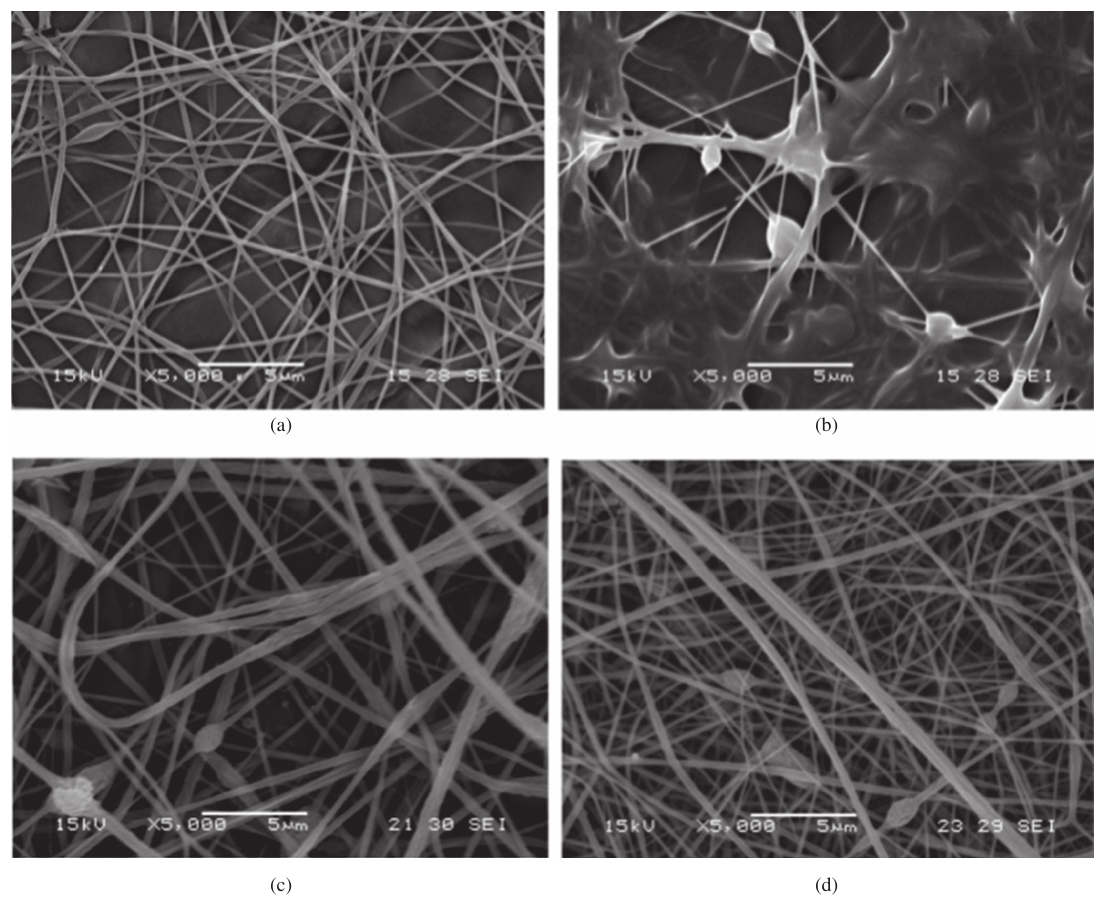
Figure 3. SEM images of a) PVA/H O; voltage : 18 kV; flow rate : 0.2 mL/h; distance : 12 cm; without Triton. b) Idem with Triton. 2 c) EC/THF/DMF; 13 kV; 0.5 mL/h; 10 cm without Triton. d) Idem with Triton. Notice that the electrospinning conditions for fiber forming are different for each polymeric system.